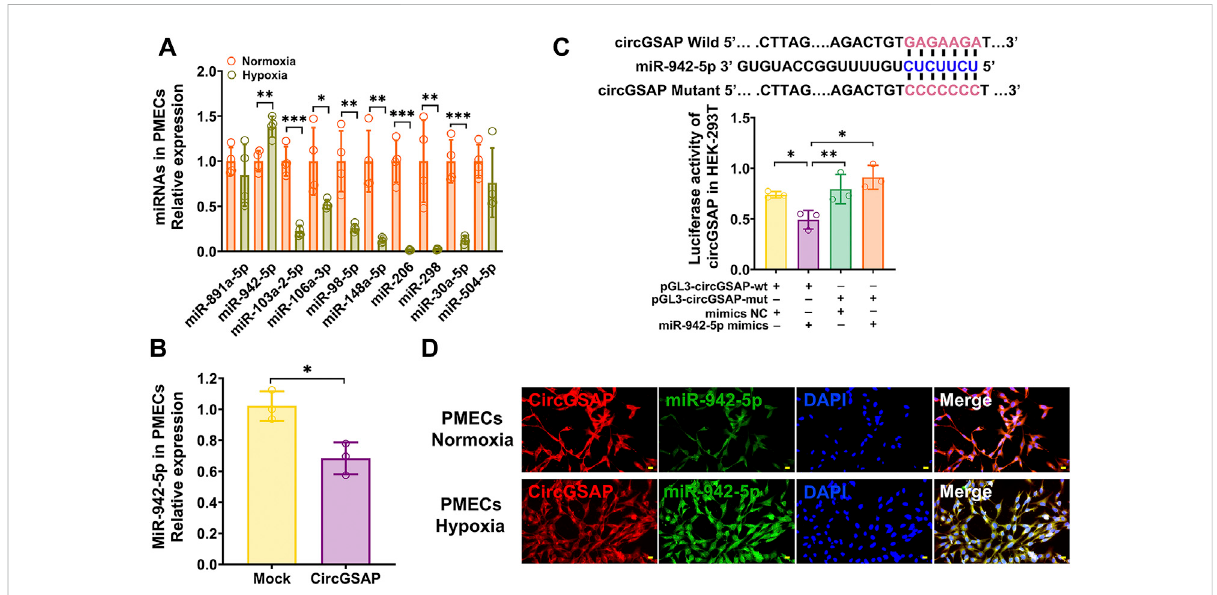
FIGURE 3 CircGSAP acts as ef fi cient miR-942-5p sponge. (A) Bioinformatics websites predicted circGSAP with associated 10 miRNAs, and qRT-PCR was used to detect miRNAs expressionlevelsin hypoxia treated PMECs ( n = 3). (B) Expression levels of miR-942-5p in PMECs with transfecting circGSAP were determined by qRT-PCR ( n = 3). (C) TargetScan predicted binding sites of circGSAP and miR-942-5p, and dual luciferase assays were used to validatetheinteractionsbetweencircGSAPandmiR-942-5p ( n =3). (D) FISHwasusedtoobservethecolocalizationofcircGSAPandmiR-942- 5p in the cytoplasm of PMECs. All data are presented as the mean ± SEM. (scale bar, 20 μ m). * p < 0.05; ** p < 0.01; *** p <